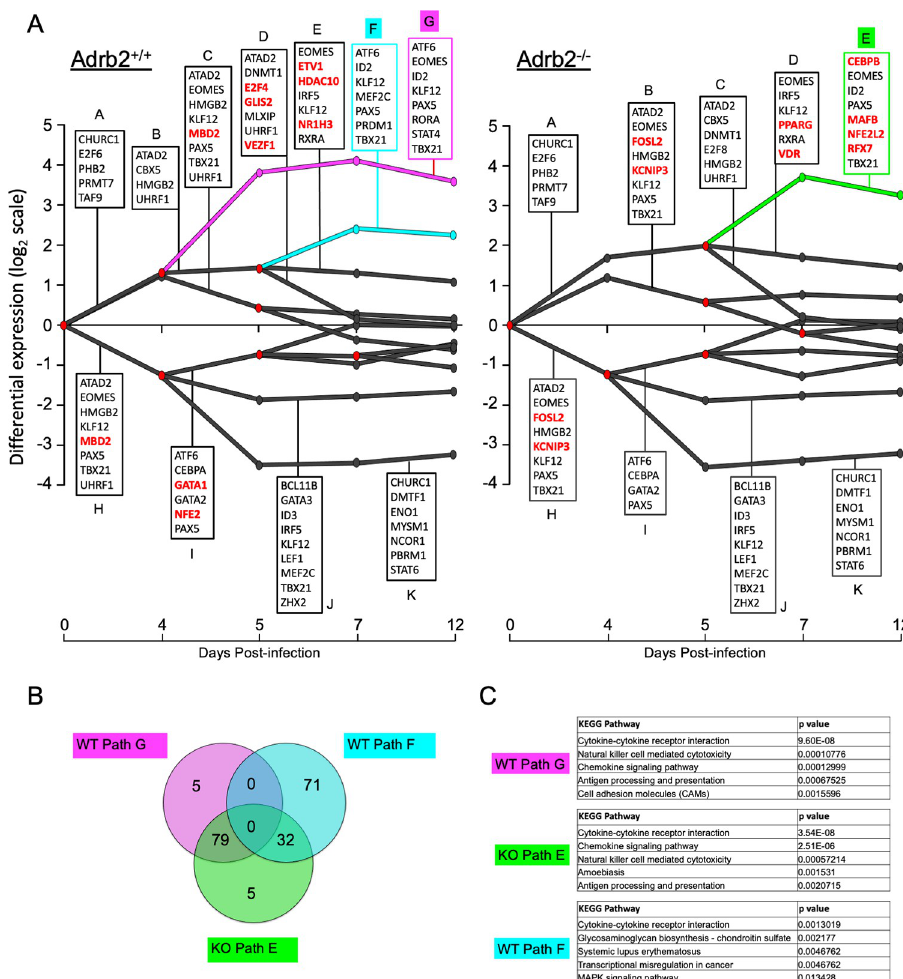
Fig 5. ADRB2 signaling coordinates temporal waves of gene expression. ( A ) SMARTS analysis at each timepoint compared to the day 0 pre-transfer condition. Each path corresponds to clusters of genes sharing common magnitude, direction of expression and regulatory factors. Red nodes in the model represent splits in expression between groups of genes. TRs predicted to regulate each split path are listed above and below their corresponding paths, and TRs in red were predicted by SMARTS to be involved in differential gene regulation between WT and Adrb2 -/- cells. WT paths F (cyan) and G (magenta), and Adrb2 -/- path E (green) contained genes and regulators which were significantly altered between the two models; they were subjected to further analyses (in B and C). ( B ) Venn analysis of constituent genes within WT paths F and G and Adrb2 -/- path E. Values represent the numbers of genes within each unique or shared segment. ( C ) Integrated KEGG pathway analysis of constituent genes of WT paths F and G and Adrb2 -/- path E. The top 5 significantly enriched pathways from each path are listed. cells, yet Tbx21 itself was not differentially expressed at any time point between the two models (Fig 6A). However, Eomes was more highly expressed in Adrb 2 -/- than WT cells on days 7 and 12 post-infection (Fig 6B), which may impact the effector to memory transition based on pre- vious studies. Within the gene sets of WT path G and Adrb 2 -/- path E, we identified several TRs that were differentially expressed at day 4 post-infection, the time point at which the major split path occurred in WT but not Adrb 2 -/- cells. These factors included Prdm1 , Pax5 , Spib , Mef2c , Mafb , and Bach2 (Fig 6C–6H). Of these factors, Pax5 and Spib are predominantly expressed in B cells and silenced in T cells [17,18], yet their transient induction in WT CD8 + T cells during infection may indicate a previously unanticipated role for them in T cell function.